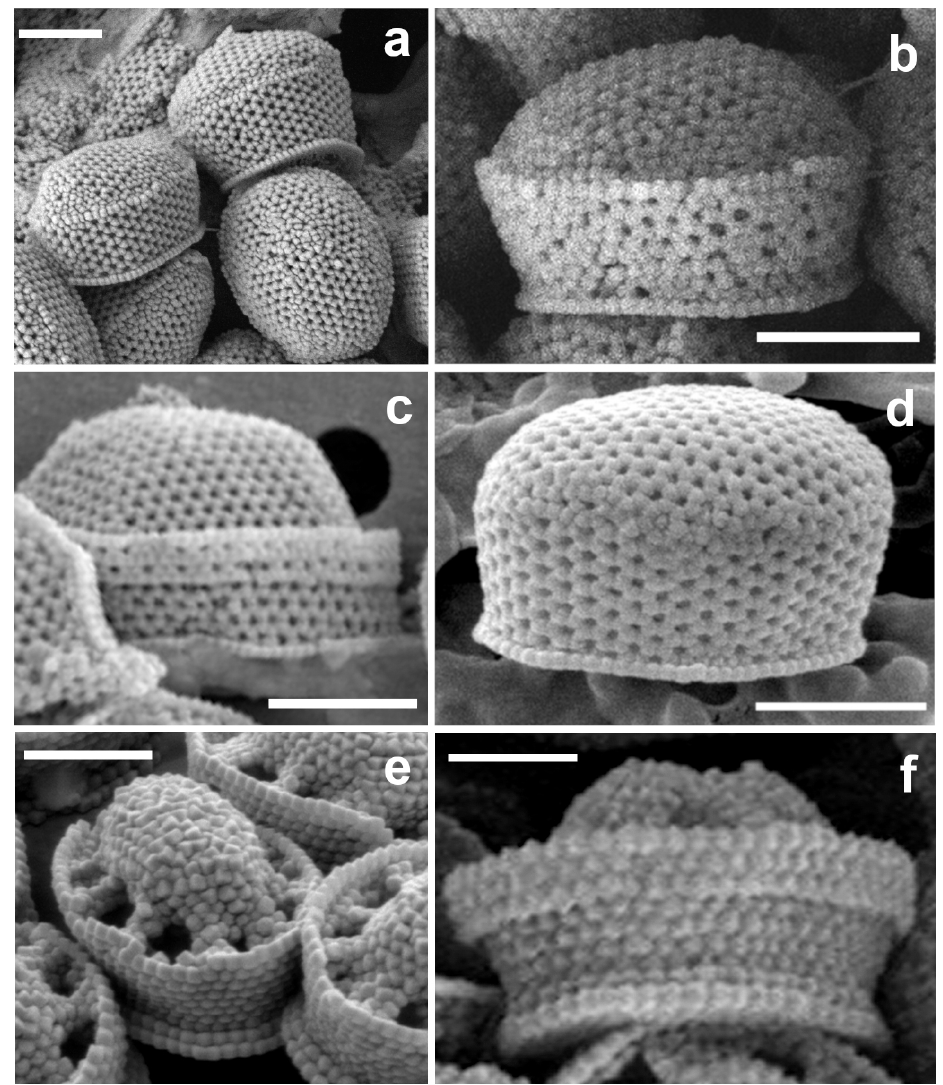
Figure 5. Close-ups of the four holococcolith types associated with Syracosphaera pulchra . (a–c) Galea -type variants (a, b) found in the GoA (17 August 2017, 40m) have a single-crystallite band separating the upper dome from the side walls, whereas (c) the typical galea variant shows a more pronounced band formed of three crystallites (AMT18 CTD089, 2 November 2008, 0m). (d) Oblonga type without a clear separation between the tube and cover (M38/1 Stn13, 29 January 1997, 5m). (e) Pirus type without and (f) with a band about three crystallites high at the top of the tube (HOTS169 Stn2, June 2004, 80m, and MATER II Stn69/12, October 1999, 35m). Scale bars: 1µm.